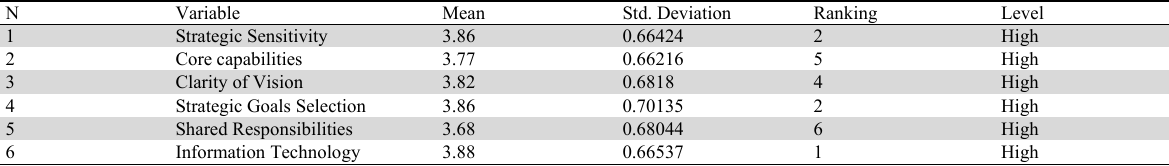
Means and Standard deviation of Strategic Agility Dimensions